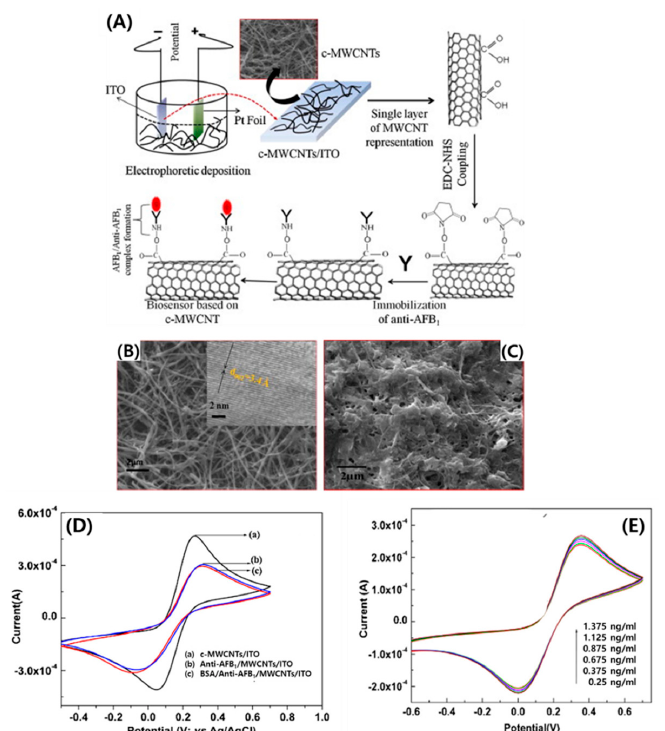
Figure 3. ( A ) Schematic illustration of the electrochemical biosensor based on carboxylated MWCNTs for aflatoxin B 1 detection. SEM images of the c ‐ MWCNTs/ITO films ( B ) before and ( C ) after anti ‐ AFB 1